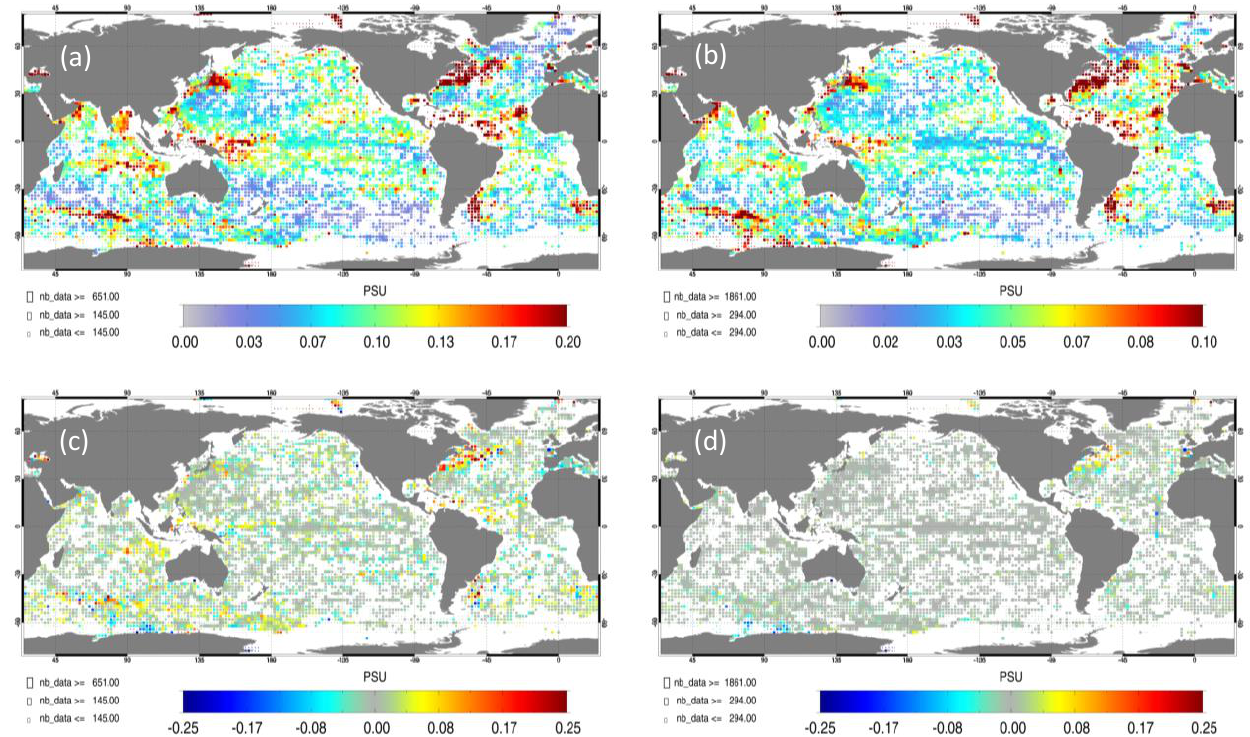
Figure 11. Spatial distribution of the RMS and the mean salinity differences between Run-Ref and in situ observations in the 0–300 and 700–2000m layers over the last 6 months of the experiments. (a) shows the RMS salinity differences in the 0–300m layer. (b) shows the RMS salinity differences in the 700–2000m layer. (c) shows the mean salinity differences in the 0–300m layer. (d) shows the mean salinity differences in the 700–2000m layer. The size of the colored boxes is proportional to the number of observations falling into that 2 ◦ × 2 ◦